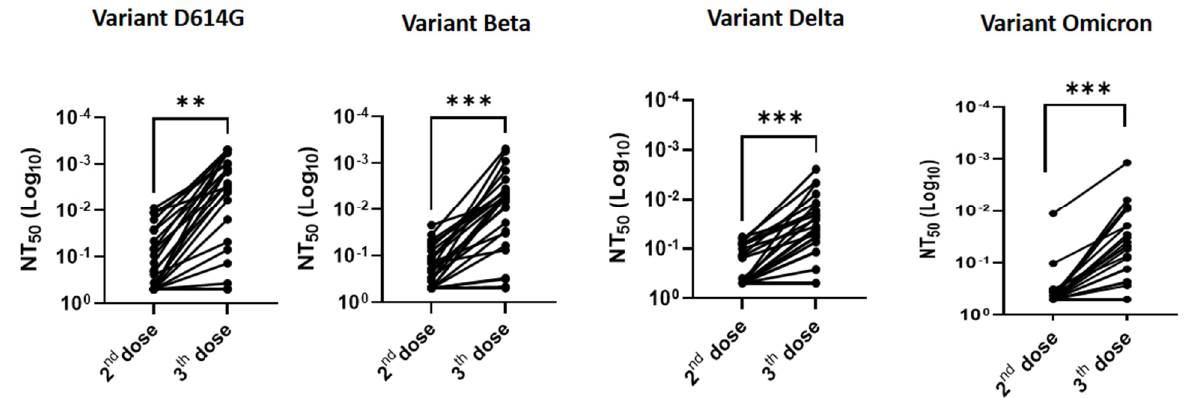
Figure 3. Changes in serum-neutralizing effectiveness against variants D614G, beta, delta, and Omicron (BA.1) after a third dose of BNT162b vaccine compared to post-second vaccine dose in allogeneic HSCT recipients from the ImmunoSupp-V group. The experiments were performed in triplicate. Asterisks indicate p -values as **: p < 0.01 and ***: p < 0.001.